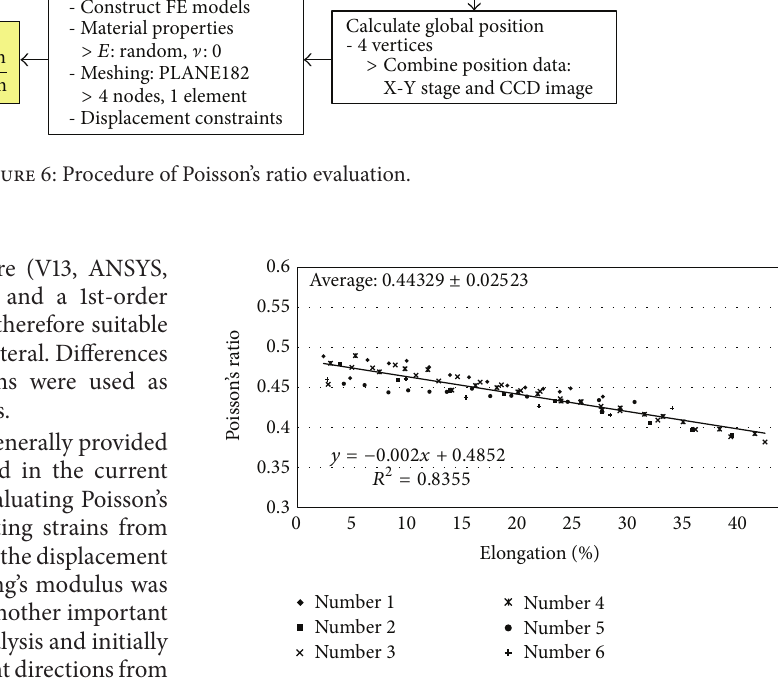
Figure 7: Poisson’s ratio of the PVA-H as a function of elongation (different samples are denoted by different symbols in the